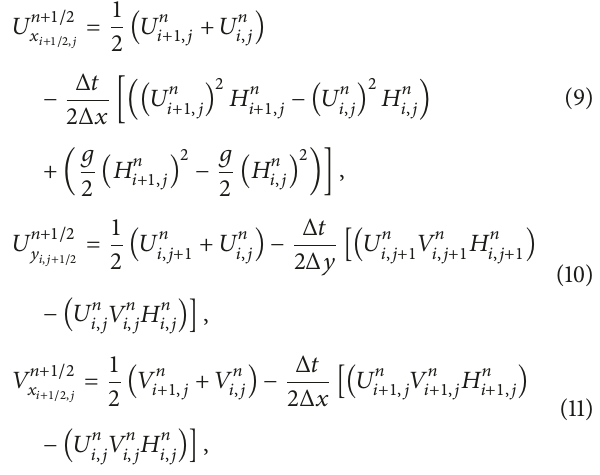
points are defined by 𝑥 𝑖 = 𝑖Δ𝑥 for all 𝑖 = 0, 1, 2, . . . , 𝐿